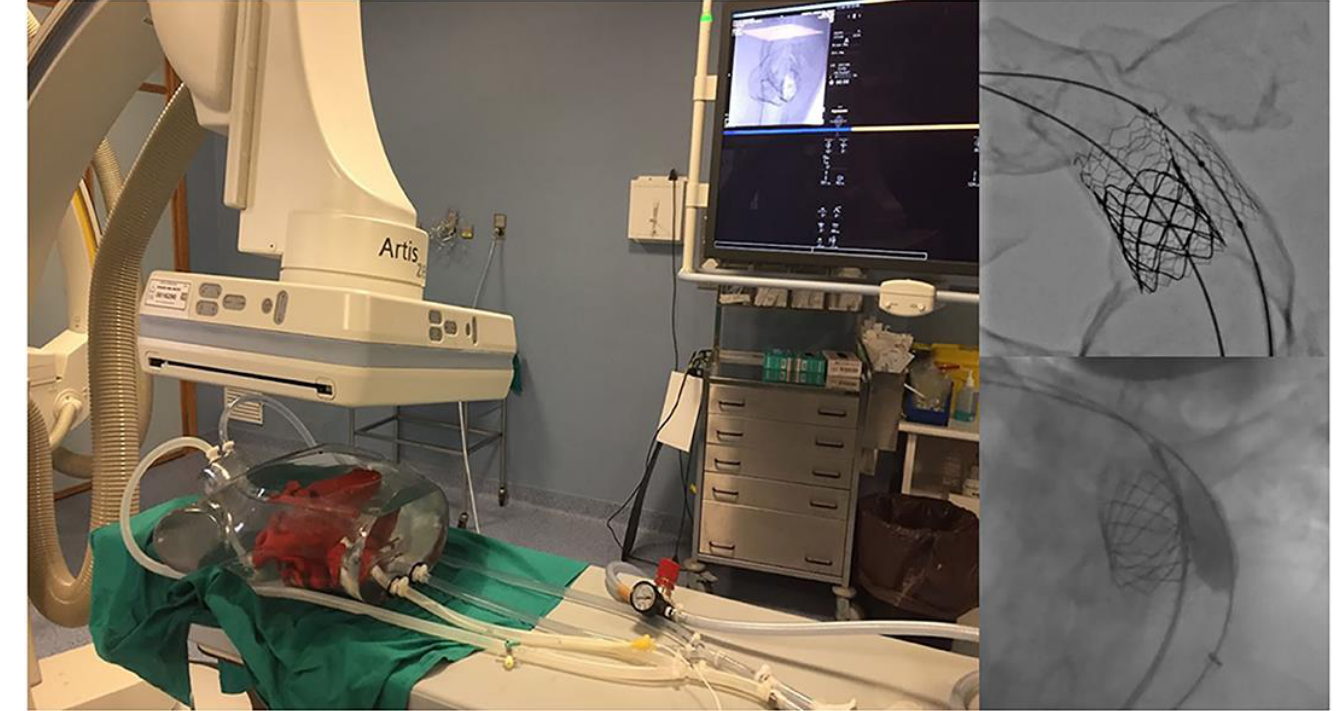
Figure 11. Catheterization applications. Left image shows the fluid inlets and outlets to superior and inferior vena cava and aortic arch/branches, respectively. Interventional planning with 3D-printed model (up right) and real intervention in the patient (down right). Reprinted with permission under the open access from Gomez-Ciriza et al. [21].